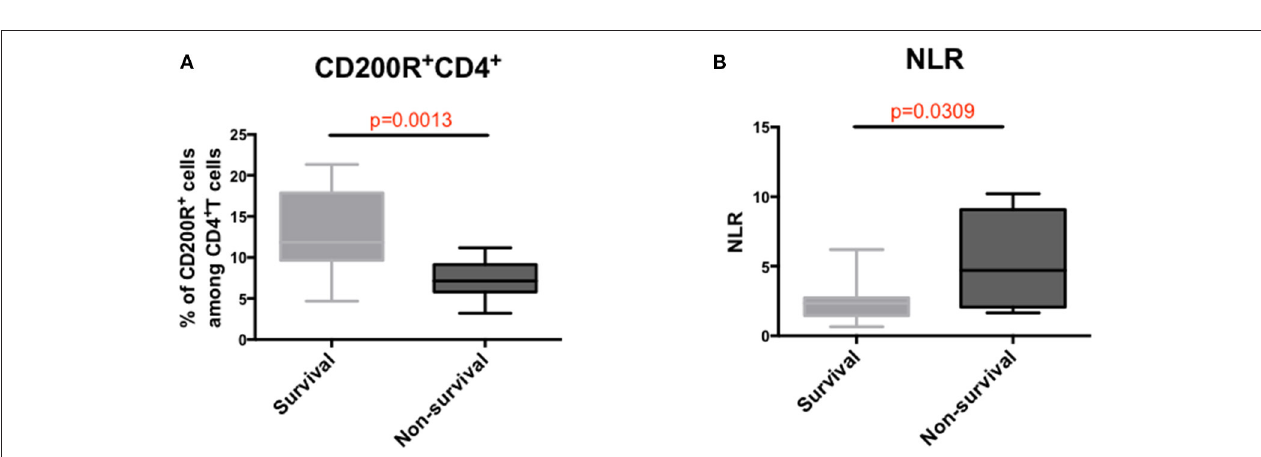
FIGURE 4 | Analysis of prognostic factors in patients with ACLF. (A) Comparison of the proportions of CD200R + CD4 + T cells in ACLF survival and non-survival groups. (B) Comparison of NLR levels between survival and non-survival groups with ACLF. A Mann–Whitney test was used to analyze statistical differences.